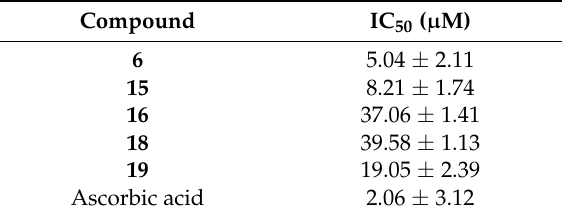
Table 1. DPPH-radical-scavenging effects of flavonoid compounds isolated from Artemisia argyi